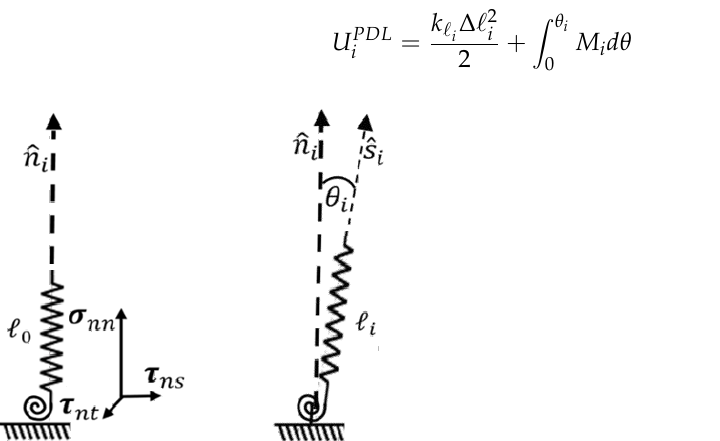
Figure 2. PDL model: A single spring block occupying a portion of the tooth surface (lower end) is anchored to the alveolar bone (upper end). Each block is comprised of paired linear and torsional springs ( left ). The springs undergo both linear ℓ 𝑖 − ℓ 0 and shear tan(𝜃 𝑖 ) deformations ( right ), where ℓ 0 denotes the spring’s initial length.